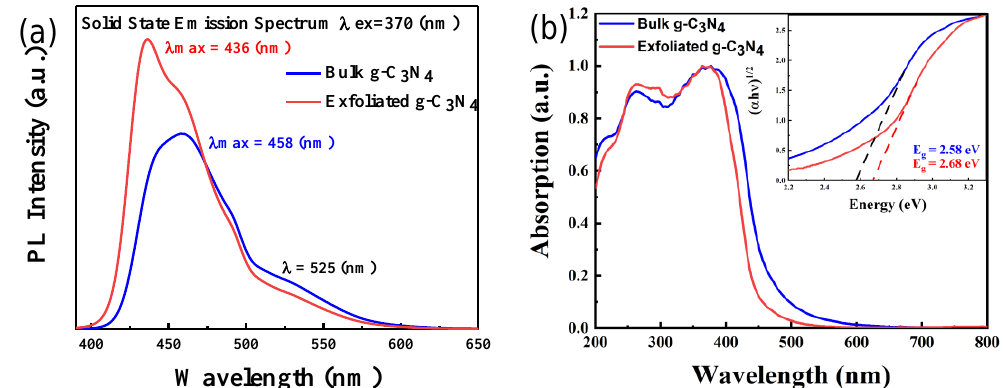
Figure 3. Photoluminescence spectra ( a ) Ultraviolet-visible absorption spectra ( b ) of bulk and exfoliated g-C 3 N 4 ; the inset of (b) shows the Tauc plots.